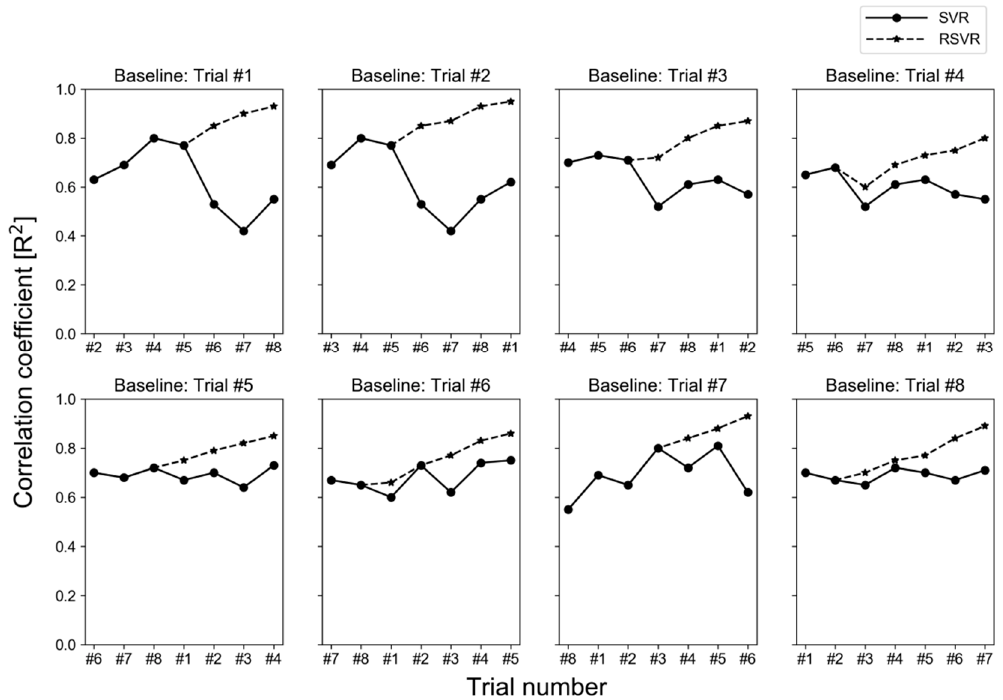
Figure 2. Comparison of the correlation between KSS score, and support vector regression (SVR) and recurrent SVR (RSVR) estimates for subject #16, with di ff erent driving trials used as